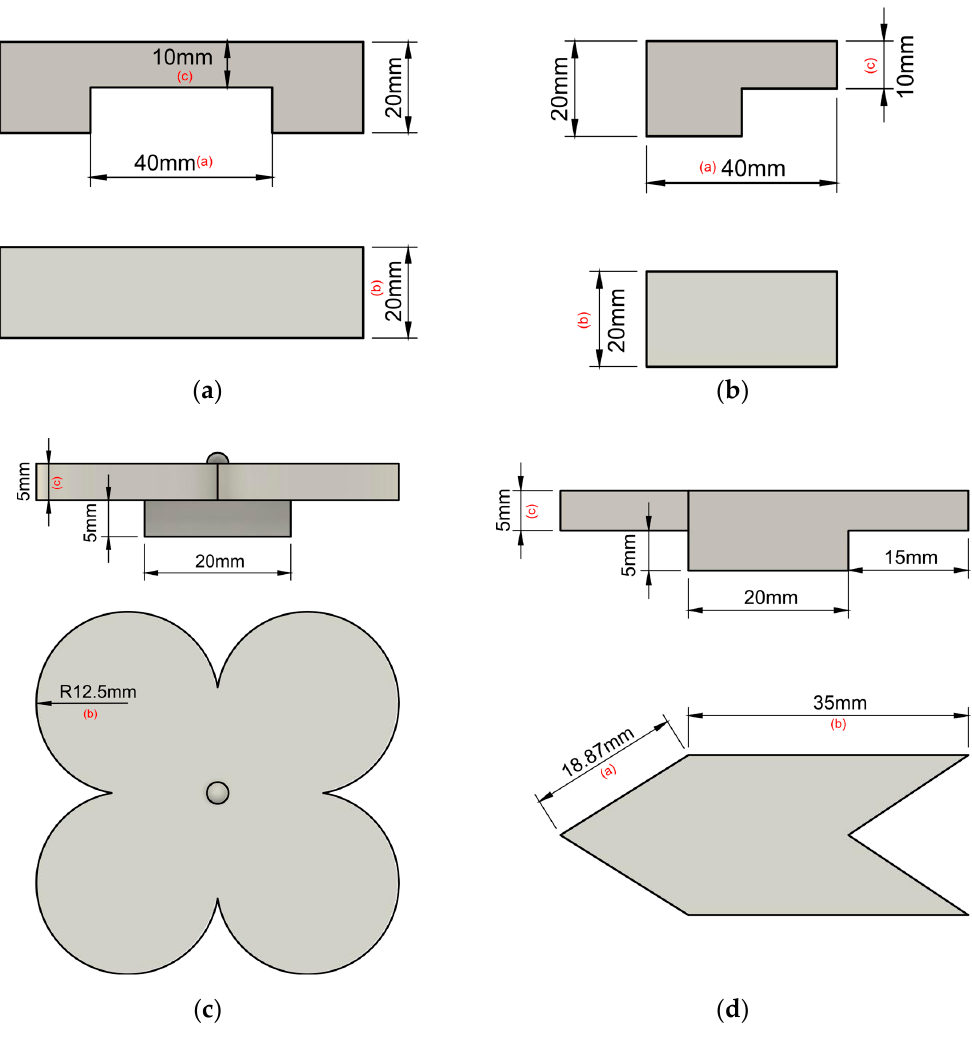
Figure 9. Test samples printed for analysis: ( a ) bridge, ( b ) rectangular 90° overhang, ( c ) circular 90° overhang, ( d ) triangular 90° overhang (pictures not in scale with each other. Letters besides dimensions refer to measured dimensions reported in Table 1).